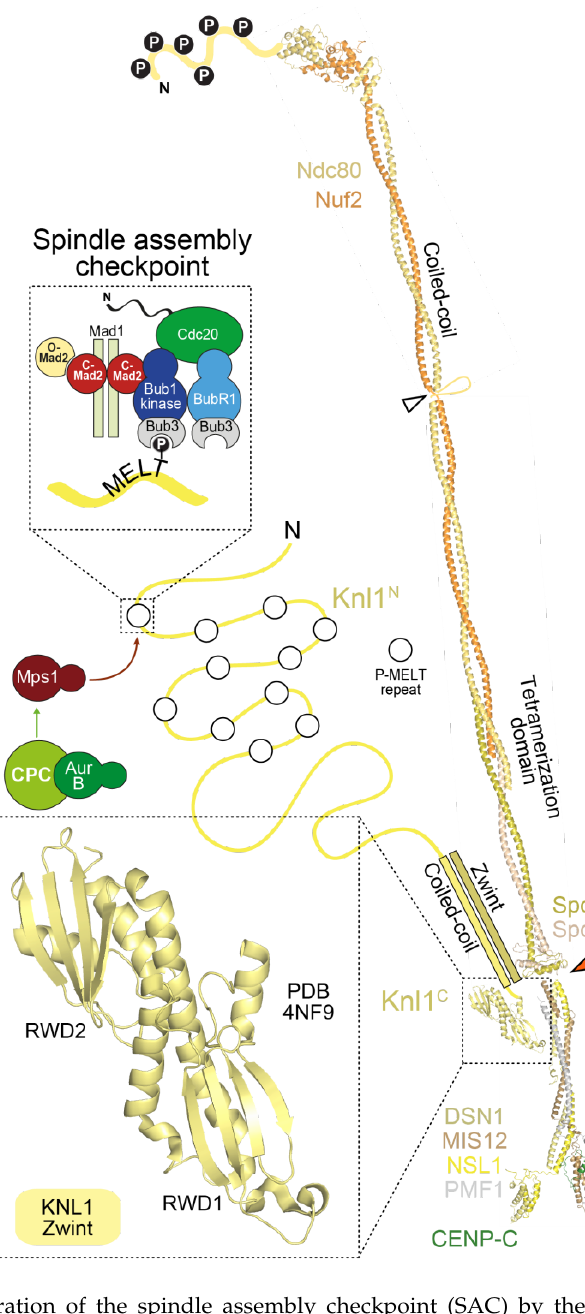
Figure 5. Orchestration of the spindle assembly checkpoint (SAC) by the KMN network SAC components are recruited via the Knl1 subunit that is 2316 residues in humans and is largely disordered. Exceptions are a predicted coiled-coil around residues 1850–2100, and the C-terminal tandem RWD domains, whose crystal structure is shown [235]. The RWD region of Knl1 binds directly to the MIS12 complex [234,235]. The N-terminal half of Knl1 contains multiple MELT repeats (Met-Glu-Leu-Thr) that are targeted by Mps1 kinase (which in turn requires Aurora B kinase to become activated). Each MELT repeat has the potential to assemble active SAC complexes that signal lack of microtubule attachment and arrest the cell cycle in mitosis.